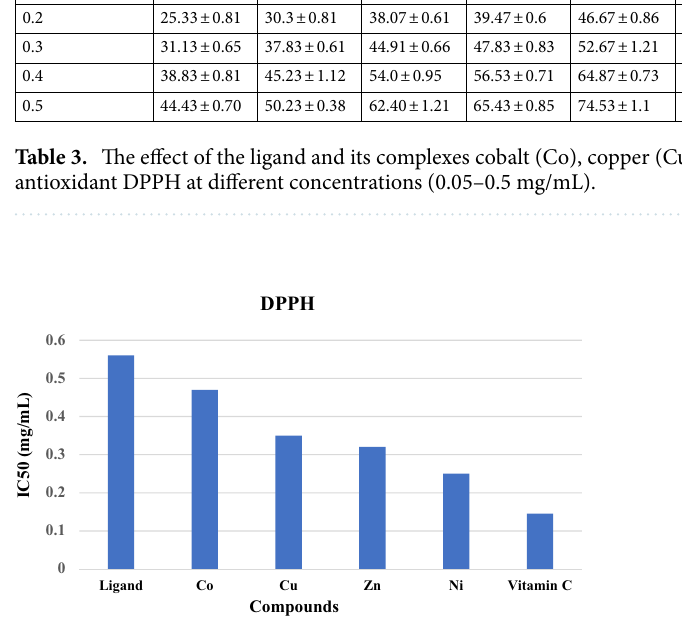
Figure 7. DPPH IC50 values for vitamin C, the ligand, and its metal